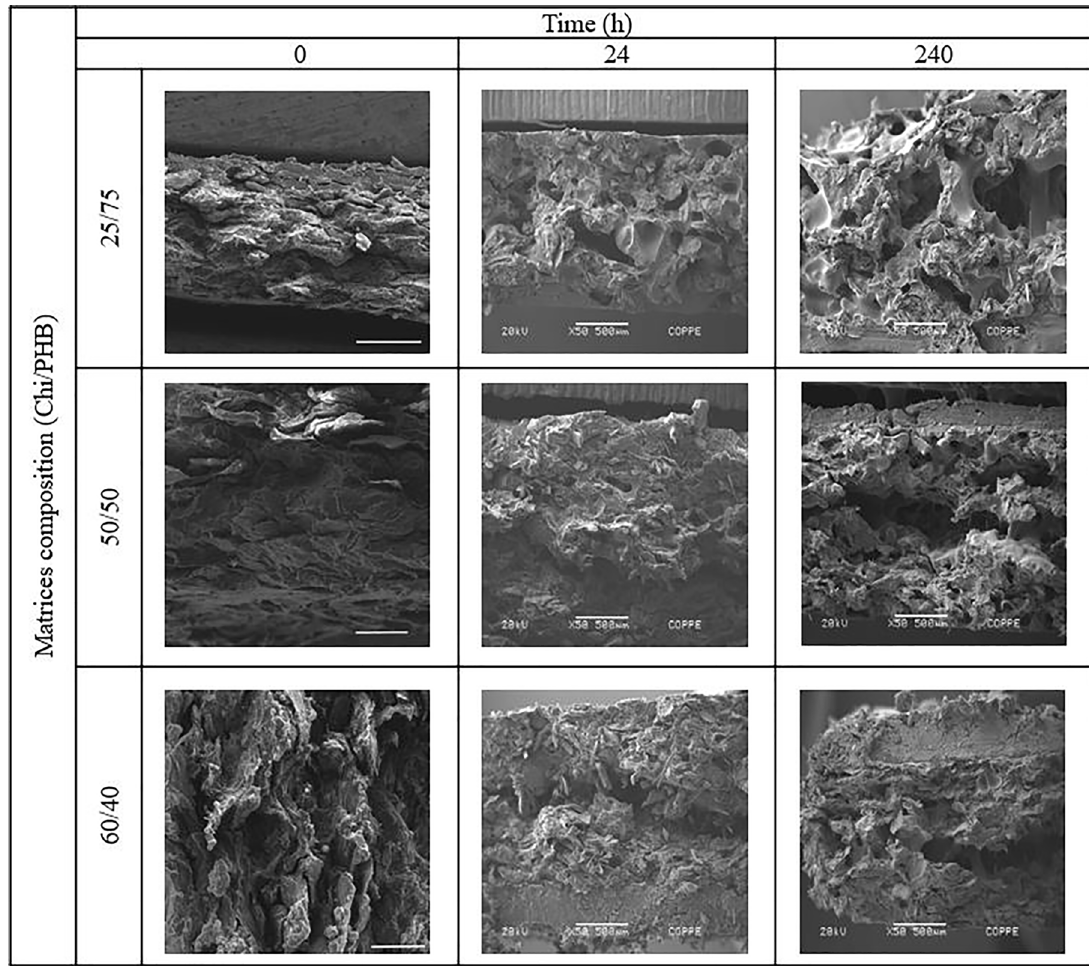
Figure 4. SEM images of matrices (0) before swelling, (24) after 24 hours in physiological solution to CHX delivery and (240) after 10 days in physiological solution to CHX delivery.